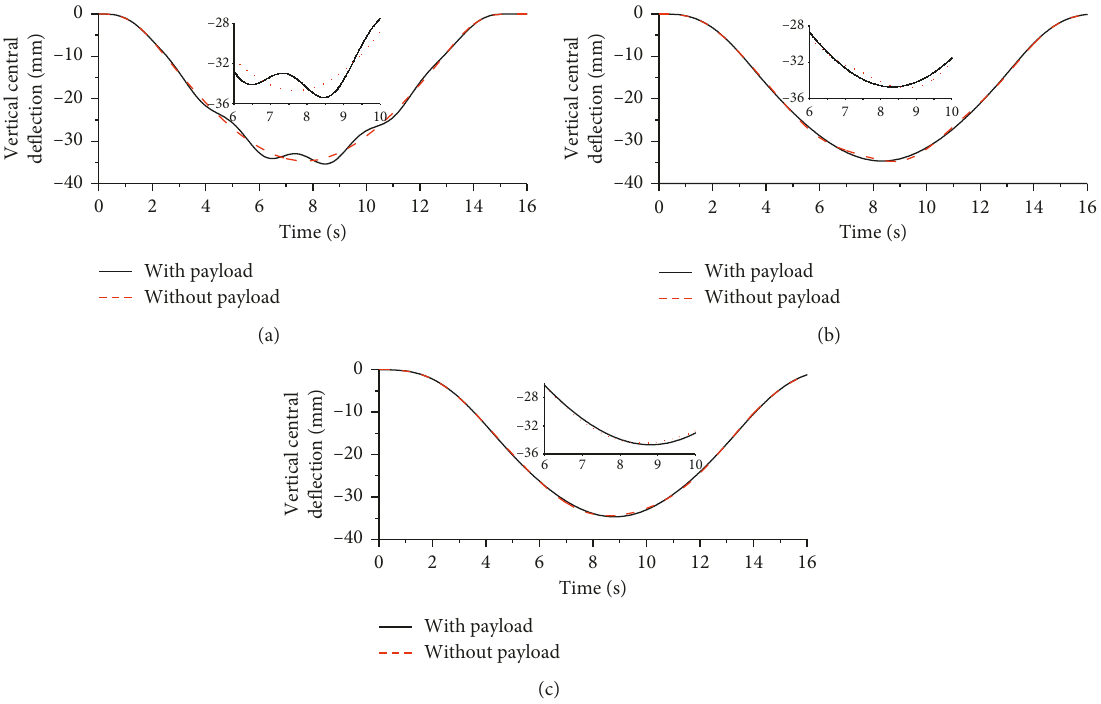
Figure 9: The deflection of a beam affected by payload swing: (a) when the cable length is 6m; (b) when the cable length is 14m; (c) when the cable length is 22m.